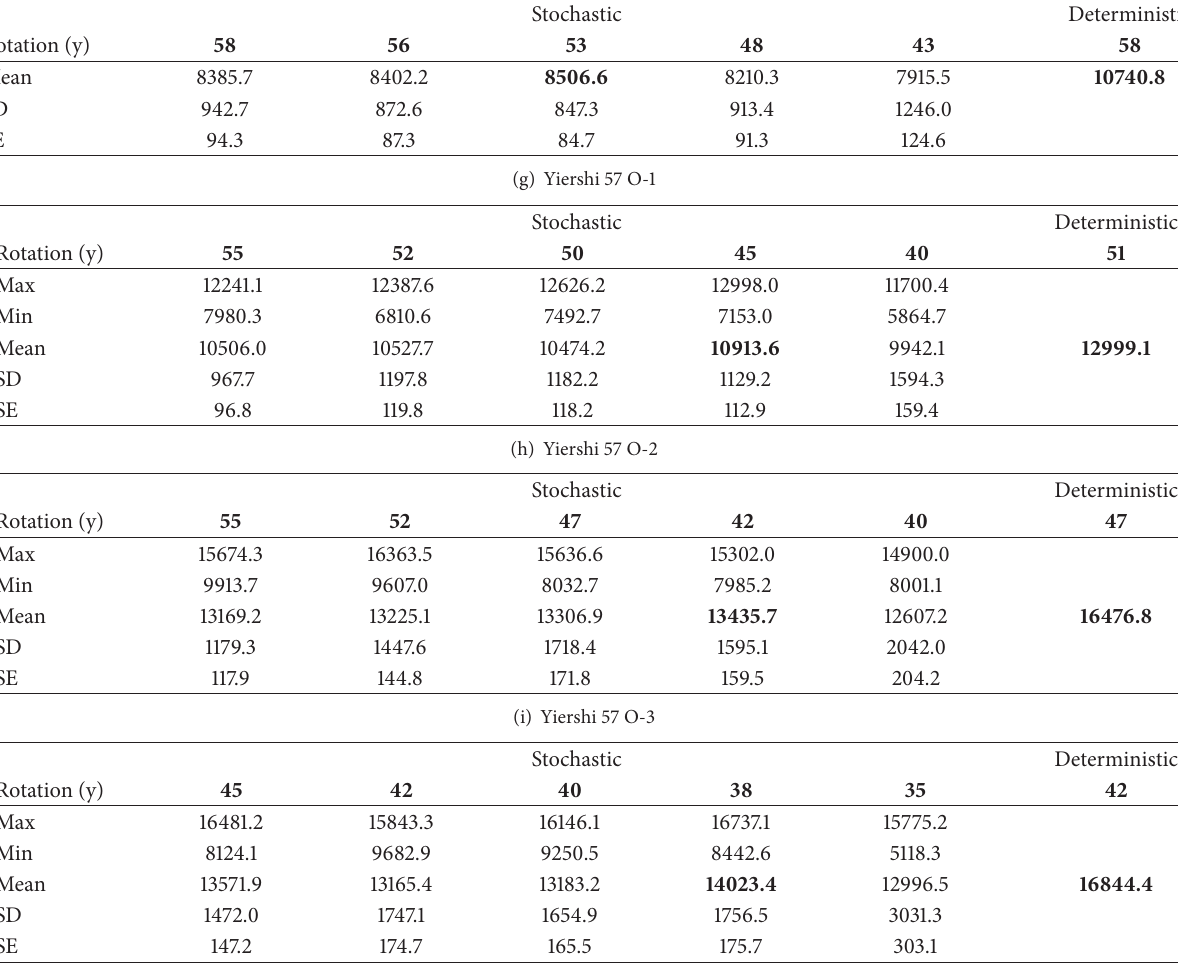
Table 3: Effect of catastrophic insect outbreak on the optimum thinning numbers. The discount rate is 3.5%. Name of plot